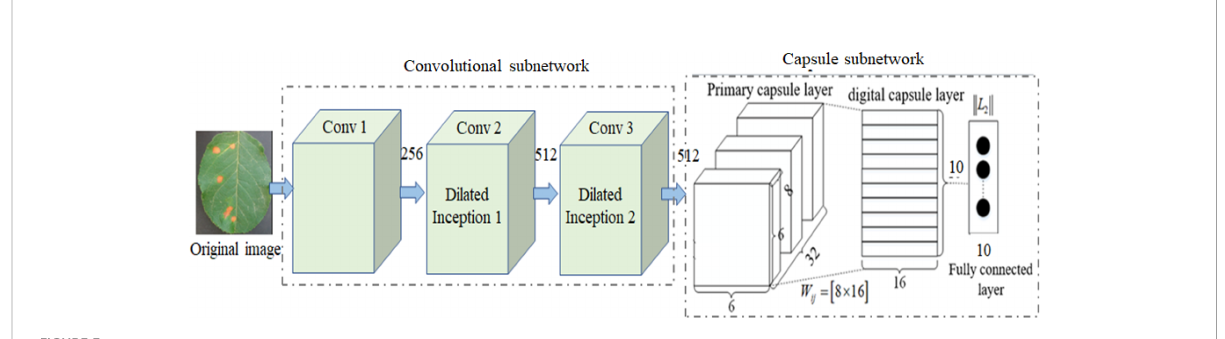
FIGURE 3 dilated convolution capsule network (DCCapsNet)